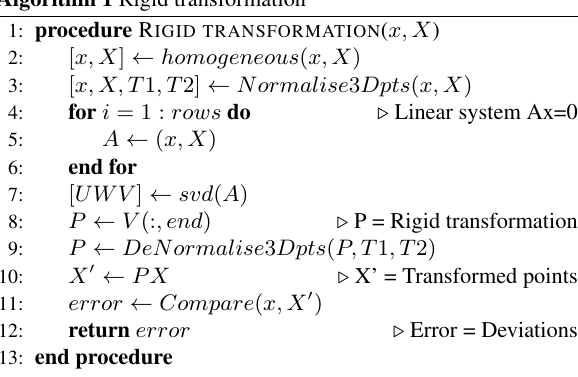
Algorithm 1 Rigid transformation